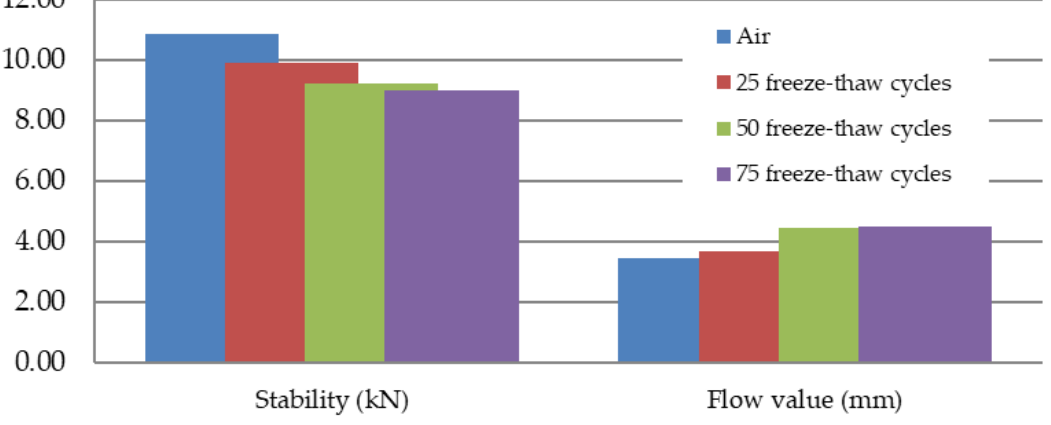
Figure 9. Relationship between the absorption of the mixture and the number of freeze–thaw cycles.